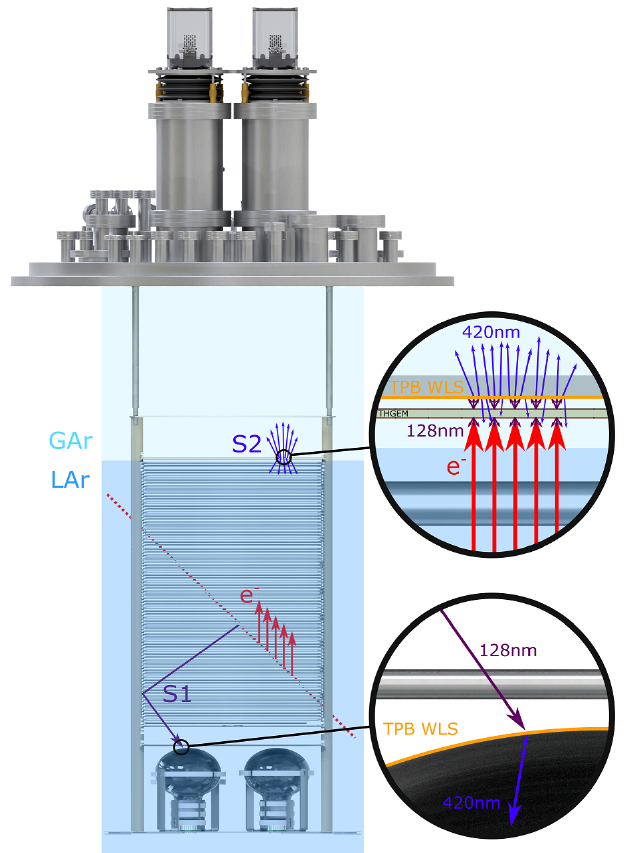
Figure 2. The detection principle of ARIADNE. A charged particle enters the active LAr volume and produces a prompt (S1) signal, which is seen by the PMTs. Simultaneously, the argon atoms are also ionised, and the free electrons drift upwards in response to the drift field. At the liquid surface, the electrons are extracted into the gas phase, and further accelerated in the THGEM holes, producing secondary (S2) scintillation light which is detected by both the TPX3Cam and the